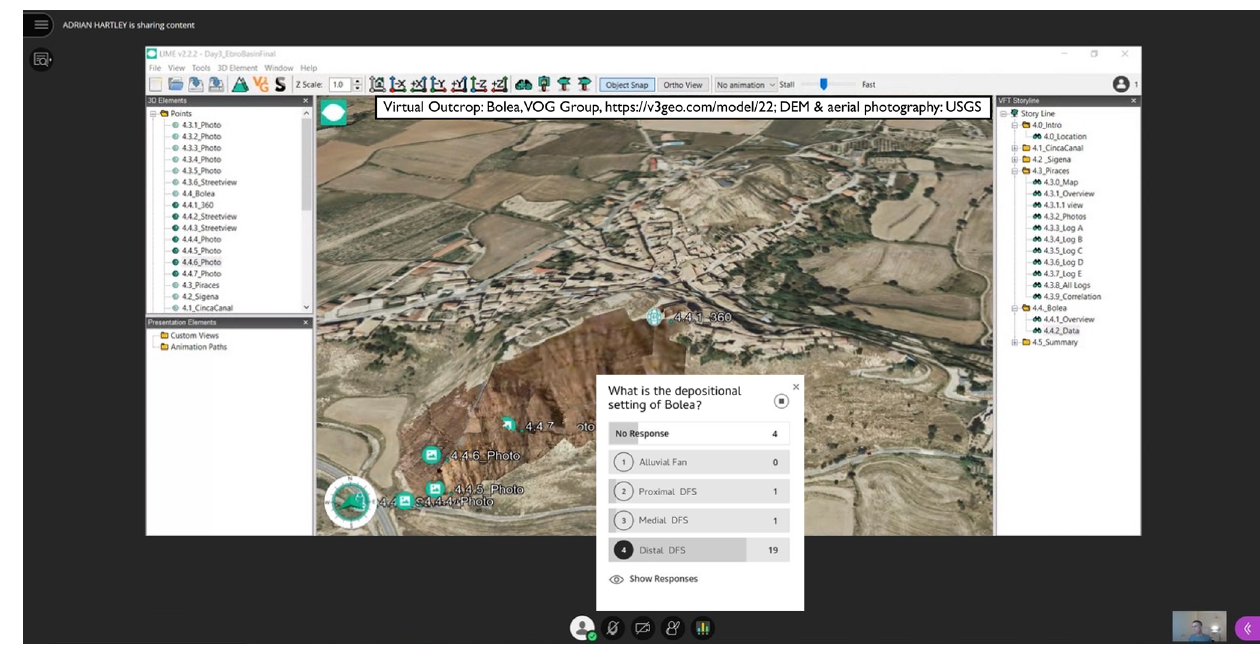
Figure 4. Bolea, Aragon, Spain; example of a poll being run within Blackboard Learn virtual classroom; students were asked to identify the depositional setting of the locality. Virtual outcrop: Bolea, VOG Group, https://v3geo.com/model/22 (last access: 4 September 2021); aerial photography on DEM, USGS EROS Archive; DEM, USGS 3D Elevation Program.